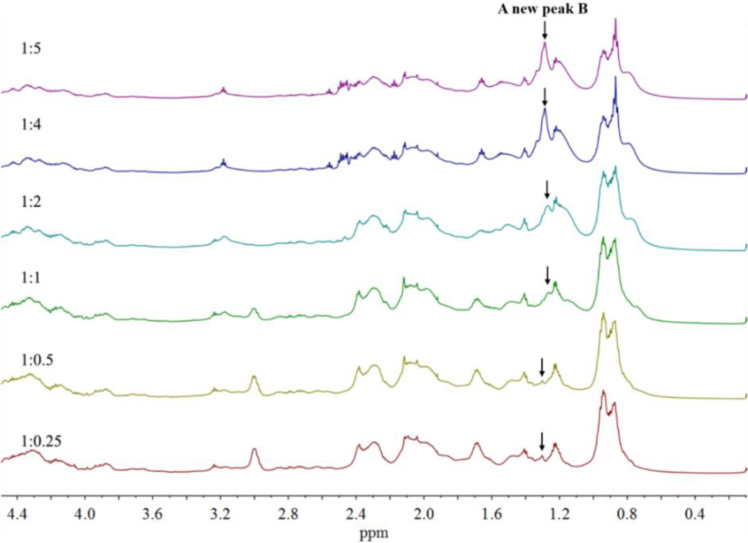
Stacked 1H NMR spectra of C12-caseinate.